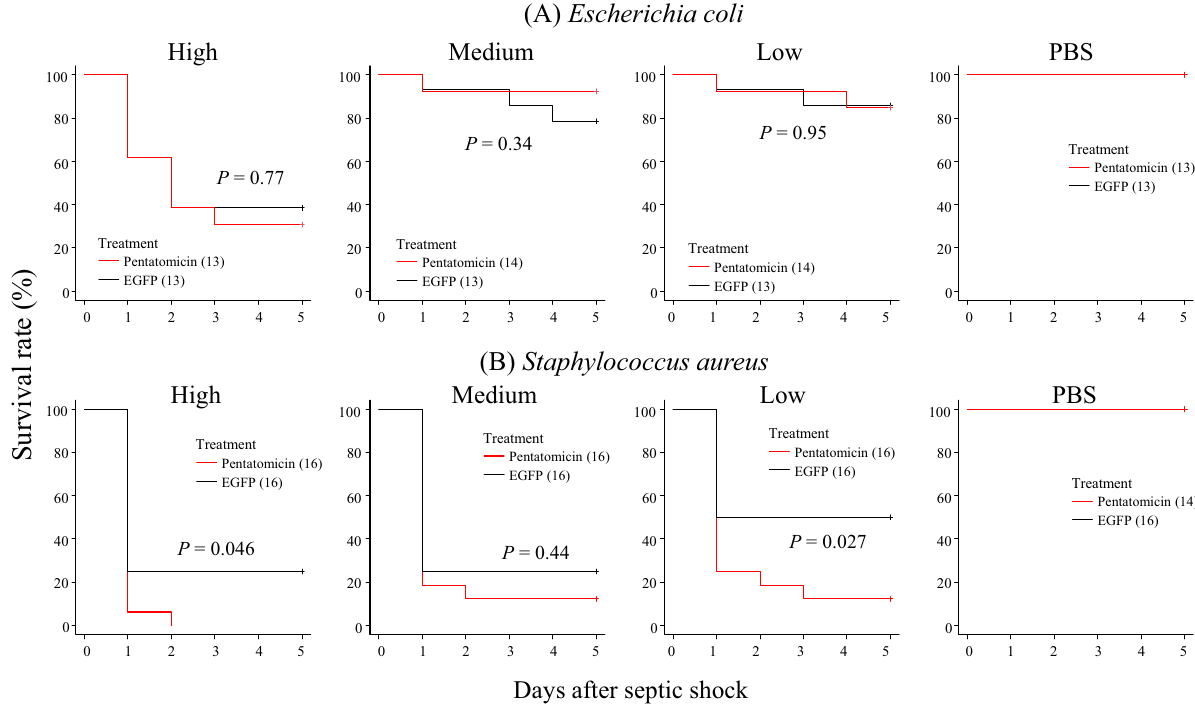
Figure 4. The effects of Pentatomicin suppression on adult survival against septic challenge by E. coli ( A ) or S. aureus ( B ). The average numbers of bacterial cells injected into P. stali adults were 1.3 × 10 10 (high concentration), 8.6 × 10 9 (medium concentration) and 4.8 × 10 9 (low concentration) E. coli cells per insect, and 5.0 × 10 8 (high concentration), 3.6 × 10 8 (medium concentration) and 2.3 × 10 8 (low concentration) S. aureus cells per insect. Red lines indicate the survival curves of Pentatomicin dsRNA-injected insects, whereas black lines show the survival curves of EGFP dsRNA-injected insects. The number of individuals is given in parentheses. P values are calculated by pairwise comparisons using Log-Rank